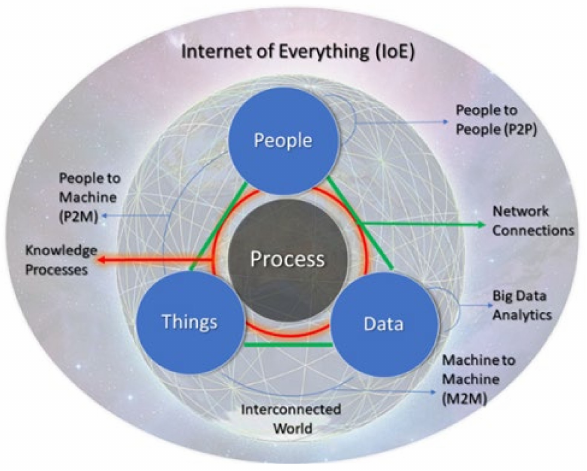
Figure 1. Internet of everything, adapted from